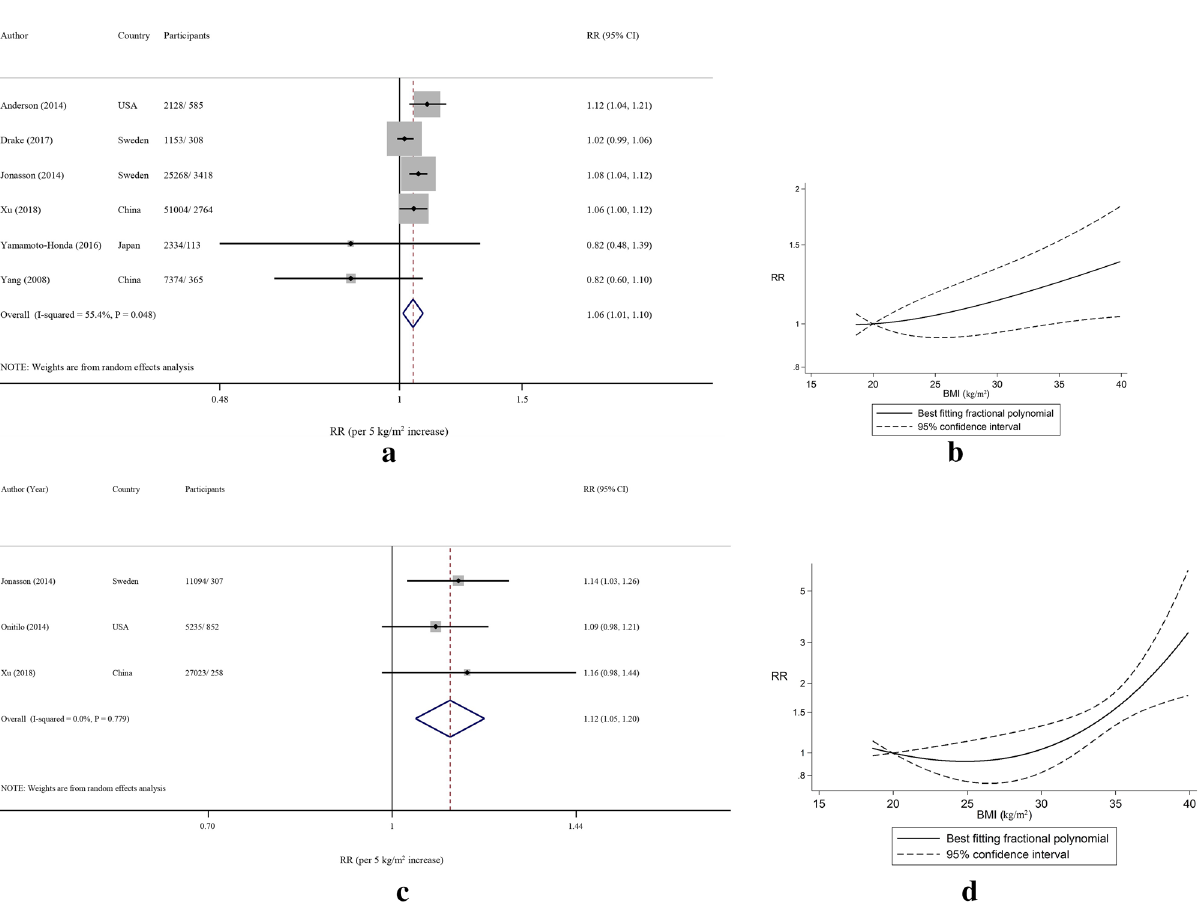
Figure 3. ( A ) Risk of total cancer associated with each 5-unit increase in body mass index in patients with T2D. The study-specific relative risk and 95% CI are represented by the black square and horizontal line, respectively; the area of the black square is proportional to the specific-study weight to the overall meta-analysis. The center of the open diamond presents the pooled RR and its width represents the pooled 95% CI. Weights are from the random-effects analysis. ( B ) Dose–response association of body mass index and total cancer risk in patients with T2D ( P non-linearity = 0.99). ( C ) Risk of breast cancer associated with each 5-unit increase in body mass index in patients with T2D. The study-specific relative risk and 95% CI are represented by the black square and horizontal line, respectively; the area of the black square is proportional to the specific-study weight to the overall meta-analysis. The center of the open diamond presents the pooled RR and its width represents the pooled 95% CI. Weights are from the random-effects analysis. ( D ) Dose–response association of body mass index and breast cancer risk in patients with T2D ( P non-linearity =